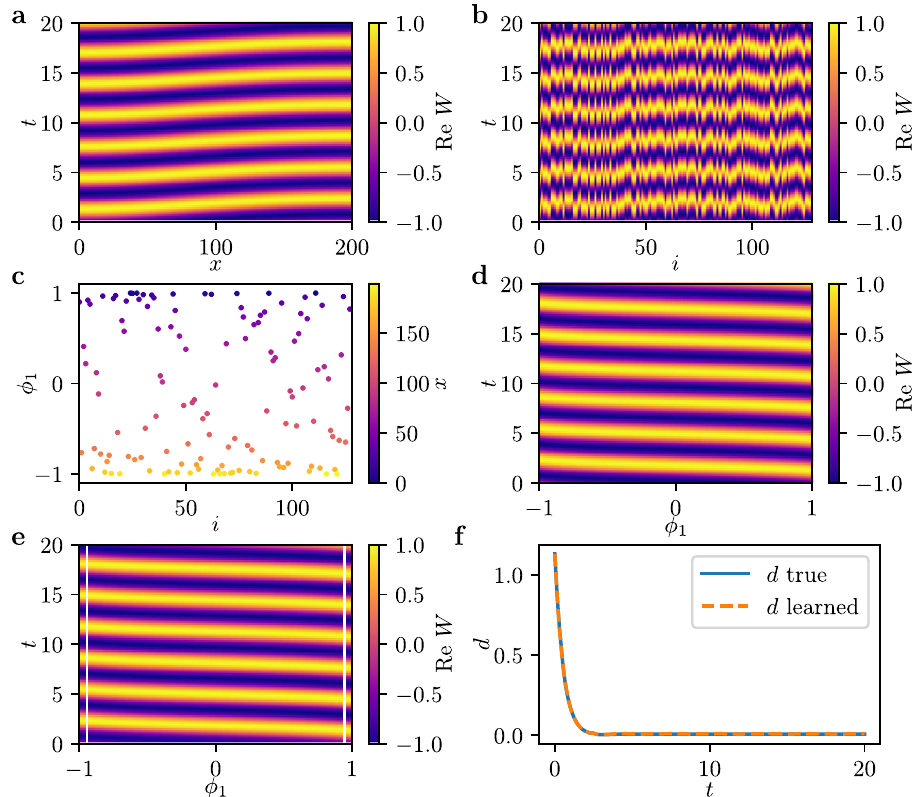
Fig. 6 Data-driven discovery of the complex Ginzburg-Landau equation. a The real part of the complex fi eld W ( x , t ) obtained from simulating Eq. (2) with N = 128 mesh points after initial transients have decayed. b Removing the spatial label yields a collection of N time series plotted here in random sequence. (c) Using manifold learning (here diffusion maps), one fi nds that there exists a one-dimensional parametrization ϕ 1 of these time series. Each point corresponds to one of the N time series, and is colored by its actual spatial location x . d The real parts of the time series parametrized by ϕ 1 . e Real part of simulation predictions for the complex variable W starting from an initial condition in our test set, using the partial differential equation model learned with ϕ 1 as the spatial variable. Since no analytical boundary conditions are available, we provide the true values near the boundaries during integration, within a corridor indicated by white vertical lines. f Smallest Euclidean distance d in C N between the transients and the true attractor at each time step: true PDE (blue), learned PDE